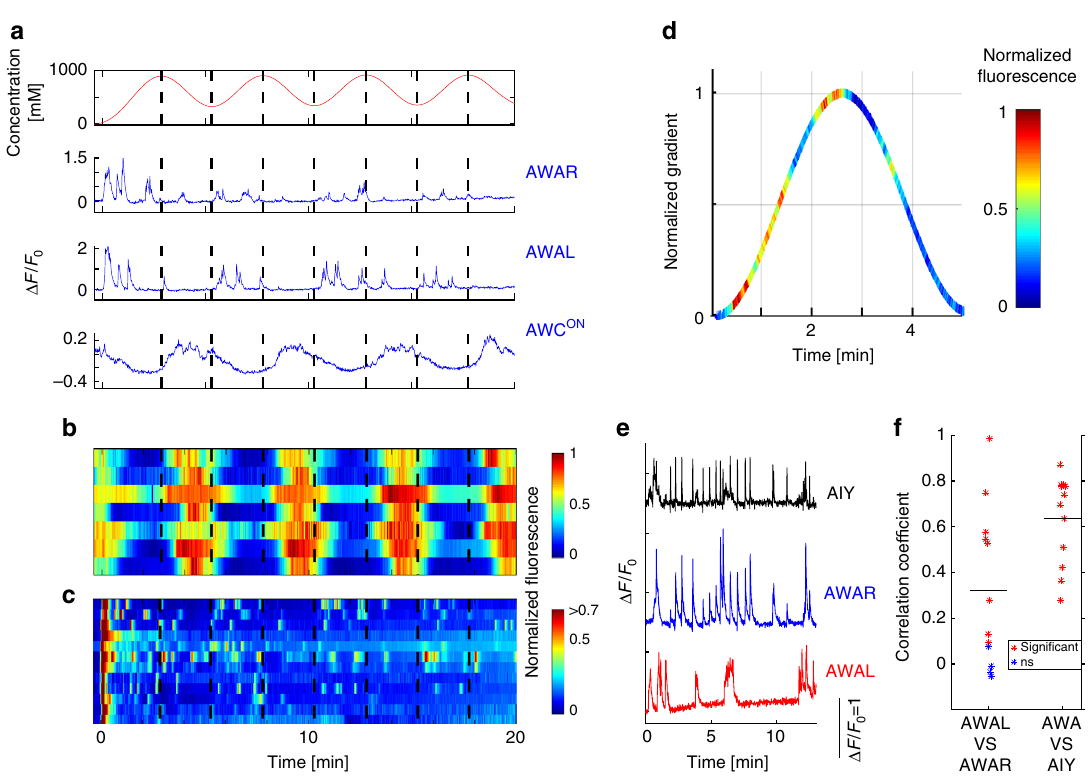
Fig. 4 AWA and AIY pulse while AWC ON shows a robust graded response. a Neural activity of AWAR, AWAL and AWC ON , as recorded in a single animal in response to a sinusoidal gradient (top). While AWA neurons stochastically pulsed, AWC ON showed a robust graded response that followed the gradual change in the gradient (for a more quantitative analysis see Supplementary Fig. 9). Dashed black lines mark the times where the gradient fi rst derivative is zero. b, c Neural responses of AWC ON ( b ) and AWAR/L ( c ) in response to the same sinusoidal gradient as in a , N = 7. Top row in b and top two rows in c are the responses shown in a . AWC ON activity was signi fi cantly stronger in the decreasing parts of the gradient ( p < 0.0002, Wilcoxon Signed-Rank test). d Mean response of the AWA neurons during a single period as calculated from all 14 AWA neurons over the second and third periods of the sine function. AWA activity was signi fi cantly stronger when the gradient was positive ( p < 0.009, Wilcoxon signed-rank test). e An example of a neural activity from the two AIY neurons (black), AWAR (blue) and AWAL (red) in response to a sigmoidal gradient. Note that activity of the two AWA neurons was often asynchronous. AIY pulses were narrower and were synced with either one of the AWA neurons. f The pulsatile activity between the bilateral symmetric AWAR and AWAL neurons was weakly correlated ( ρ mean = 0.32). Conversely, the mean correlation in activity between the sum of the two AWA neurons and AIY was signi fi cantly higher ( ρ mean = 0.64, Wilcoxon rank-sum test, p < 0.03, N = 12 different animals). Black horizontal lines mark the